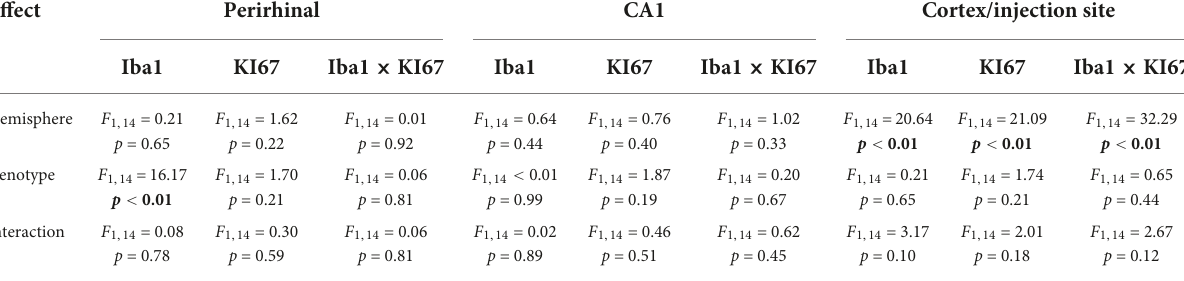
TABLE 1 ANOVA results from cell count data ( Figure 2 ) separated by brain region, histological stain, and